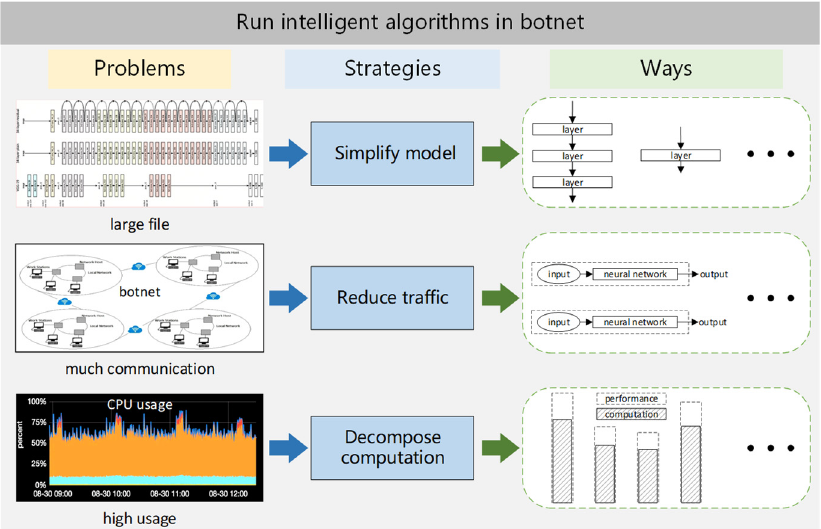
Figure 2. Idea analysis.